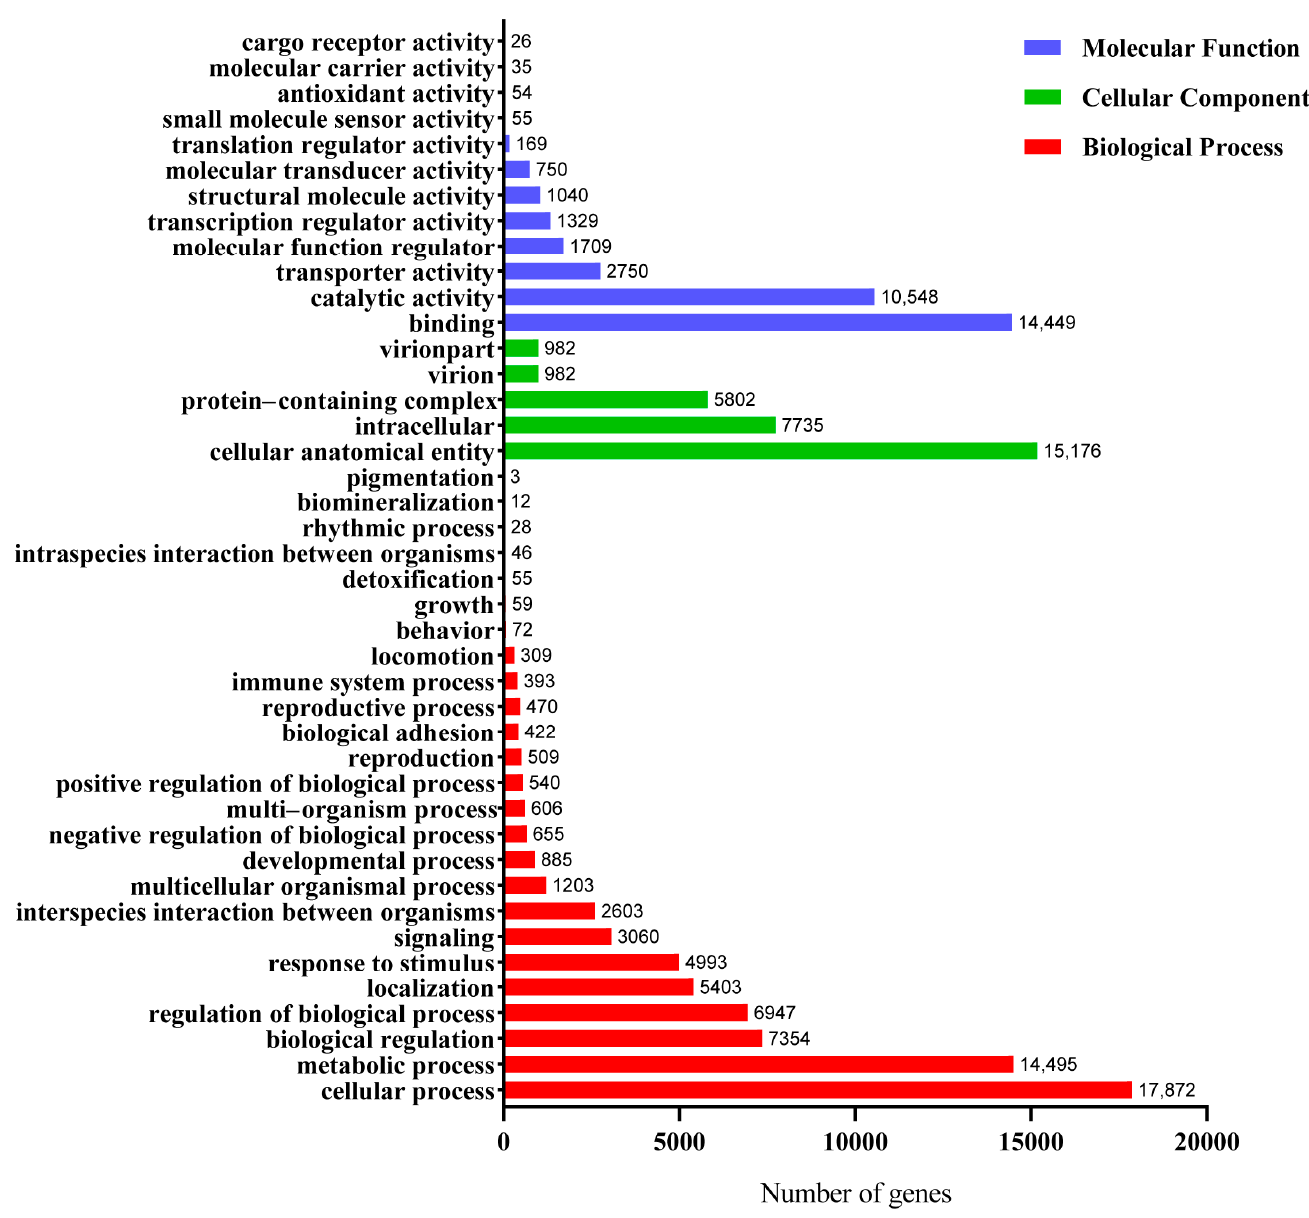
Figure 2. GO annotation of the gonad transcriptome of Macrobrachium rosenbergii .